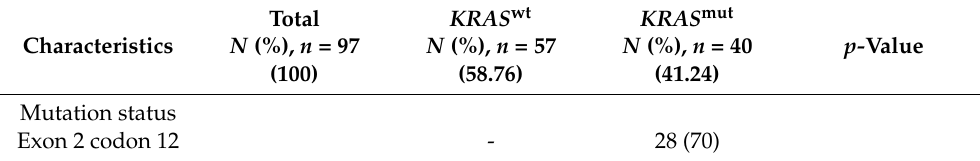
Table 1. Clinical characteristics and KRAS mut status of patients with